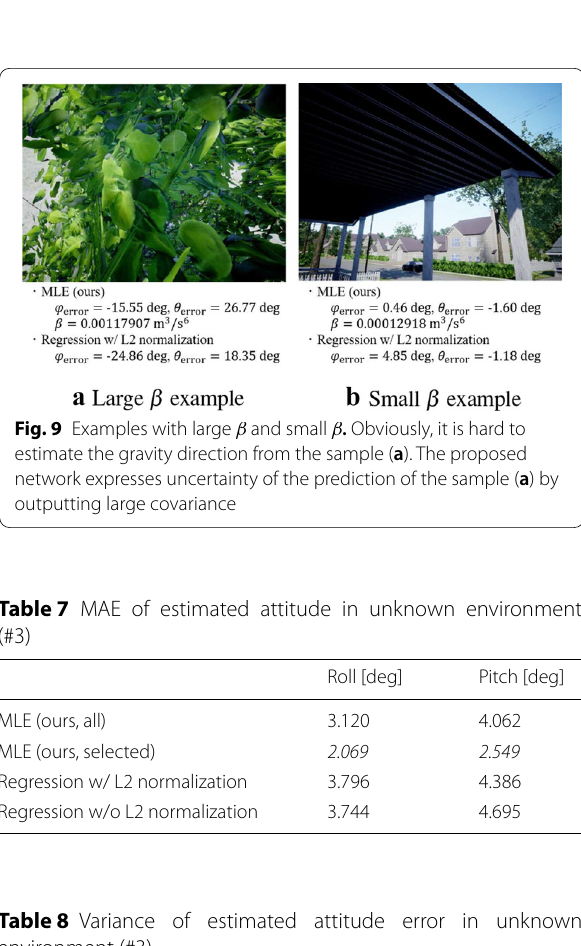
Table 8 Variance of estimated attitude error in unknown